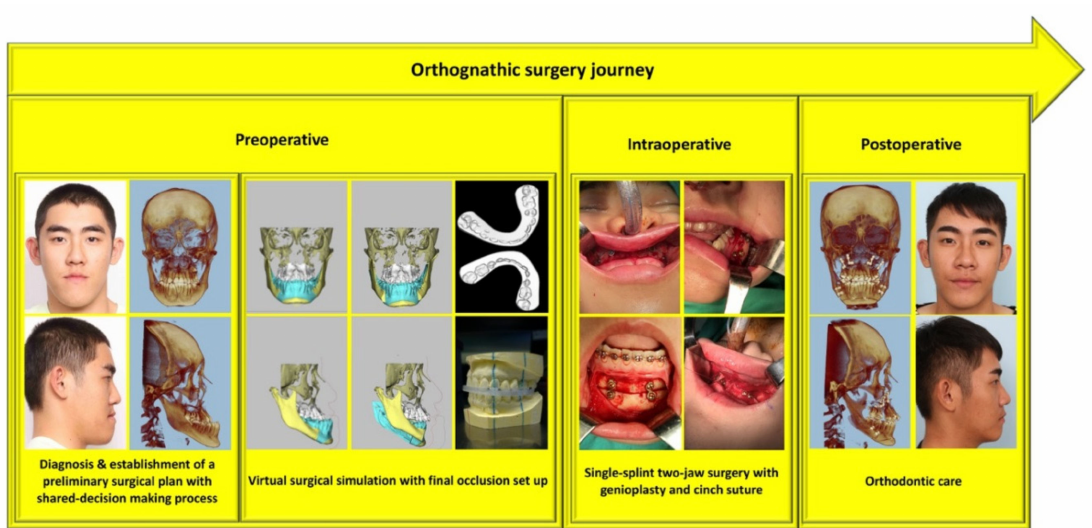
Figure 3. Multistep orthognathic surgery journey from the initial preoperative multidisciplinary-based consultation to reintegration into society after correction of facial deformity and malocclusion. Patient provided written consent for the use of his